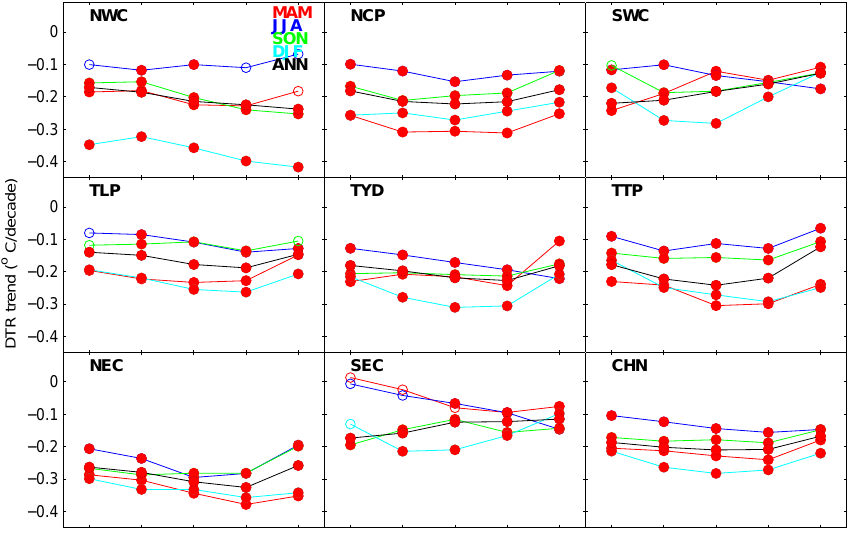
Fig. 7. Long-term trends of diurnal temperature range during 1954–2009 for different sky conditions characterized by total cloud cover. The solid circles represent that the trend is significant at the 99%